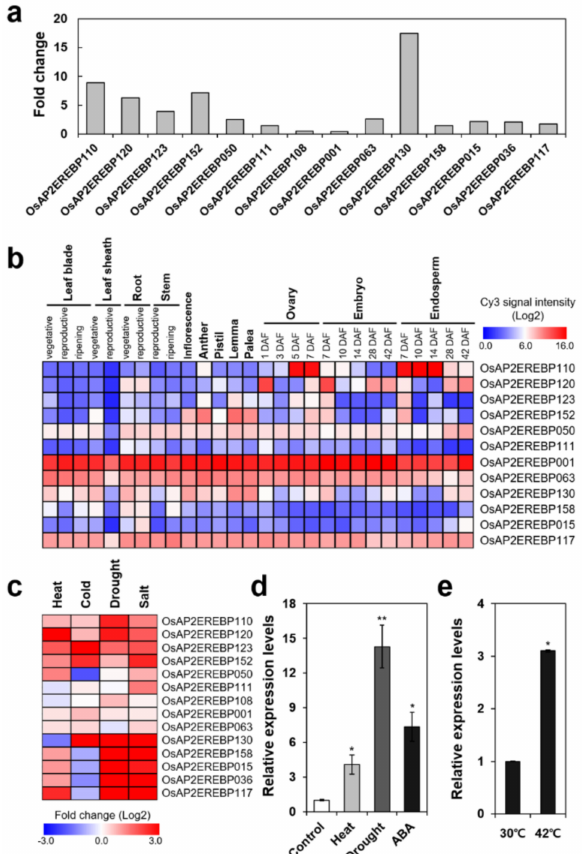
Figure 1. Expression profile of OsAP2/EREBP Group-IIIc genes. ( a ) Heat stress-induced transcript level of OsAP2/EREBP Group-IIIc genes in ripening seeds. Rice panicles at 25 DAH were incubated for 5 days at 30 ◦ C and 42 ◦ C, respectively. Transcriptomic profiling was analyzed using the Agilent O. sativa GE 180K microarray platform. Data presented as fold change of normalized intensity values for 16 Group-IIIc genes from heat treated seeds compared to the control. ( b ) Spatio-temporal gene expression analysis of OsAP2/EREBP Group-IIIc members in various tissues/organs at different developmental stages. Heatmap of the normalized Cy3 signal intensity values for 12 OsAP2/EREBP Group-IIIc genes was constructed according to the RiceXPro database. ( c ) Expression analysis of OsAP2/EREBP Group-IIIc genes in rice seedlings under various abiotic stresses. Heatmap of the normalized intensity values for 14 Group-IIIc was constructed according to the public microarray data GSE14275 and GSE6901. ( d ) qRT-PCR analysis of OsERF115/AP2EREBP110 ( LOC_Os08g41030 ) gene in rice seedlings subjected